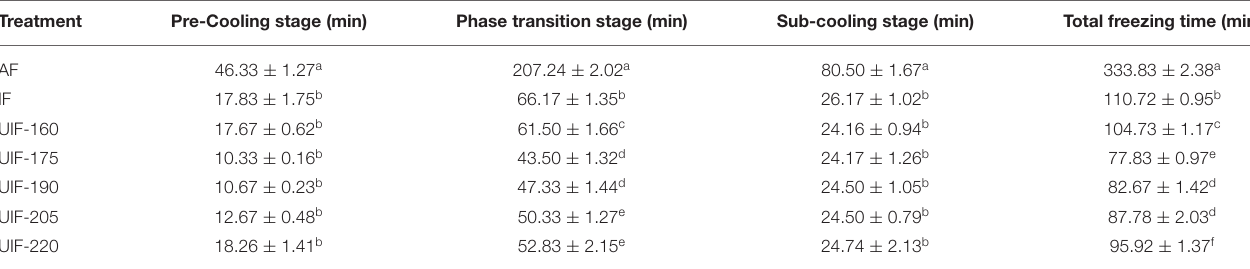
TABLE 1 | Influence of different freezing methods on the freezing time of the large yellow